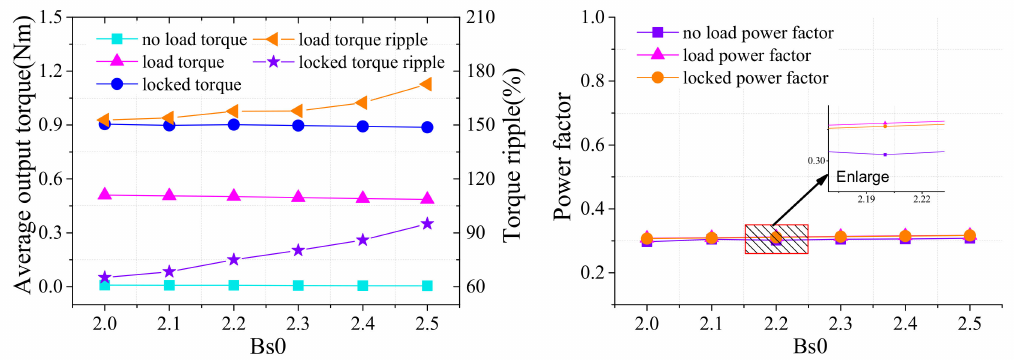
Figure 6. Influence of slot opening width on average output torque and power factor at no load, load, and locked.